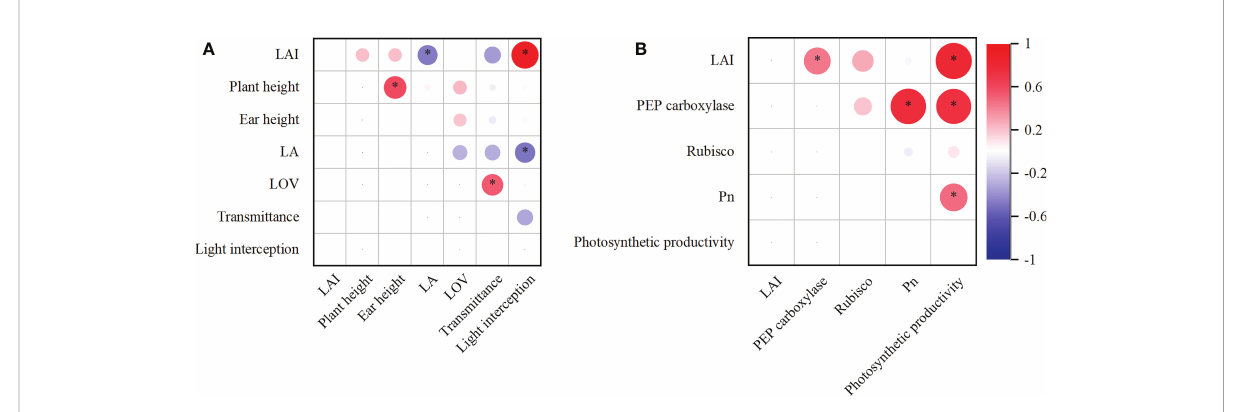
FIGURE 7 Correlation analyzed with light interception (A) and photosynthetic productivity (B)